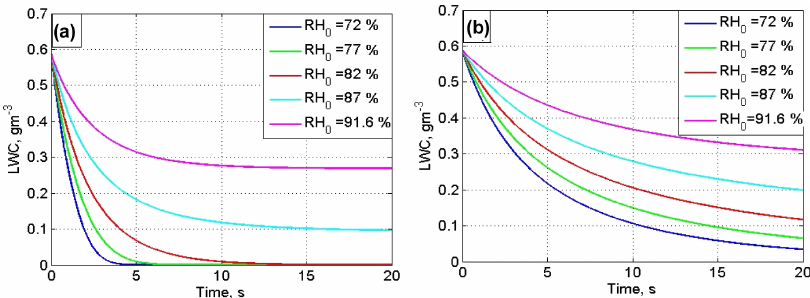
Figure 11. Time dependencies of LWC calculated using a parcel model at different values of RH 0 in the resulting volume, for an initially narrow DSD (a) and an initially wide DSD (b) . The thermodynamic parameters are the same as in Fig. 7. The parameters of the initial DSDs are given in Table 3.